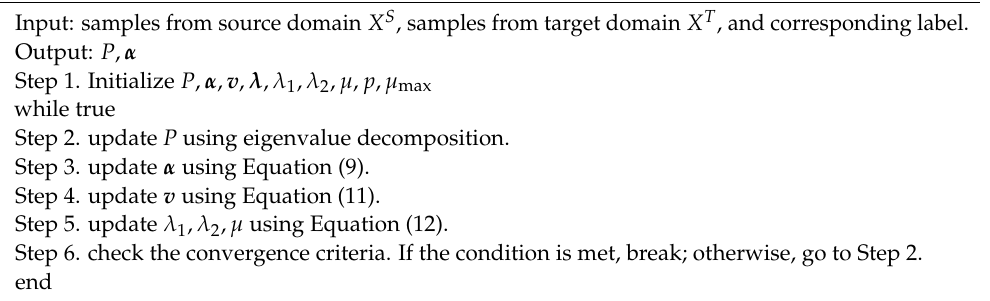
Algorithm 1. JFSSS-HFT Optimization